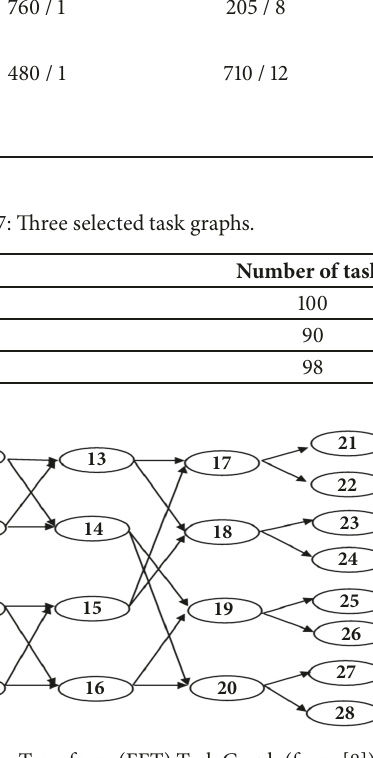
Figure 11: Fast Fourier Transform (FFT) Task Graph (from